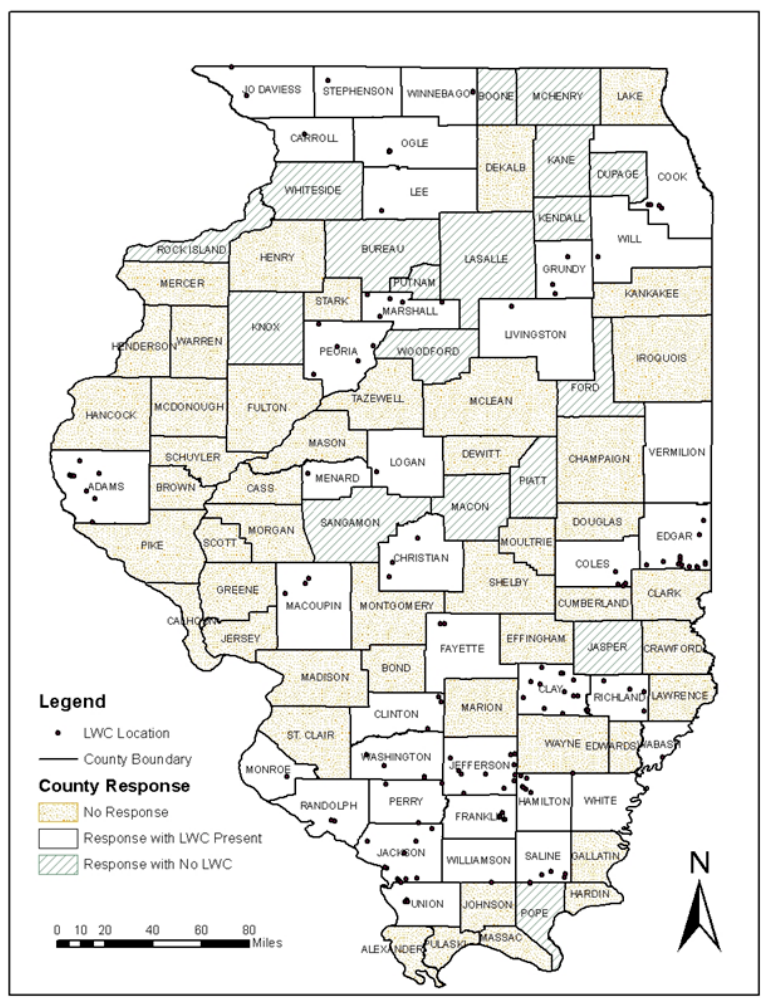
Figure 4. Location of low-water crossings (LWCs) in the Illinois counties.